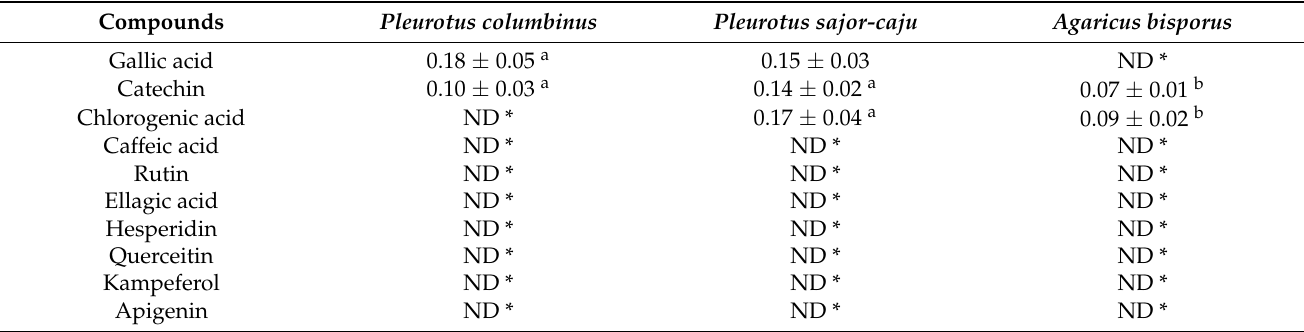
Table 2. Phenolic and flavonoid composition of mushroom Sp . ( µ